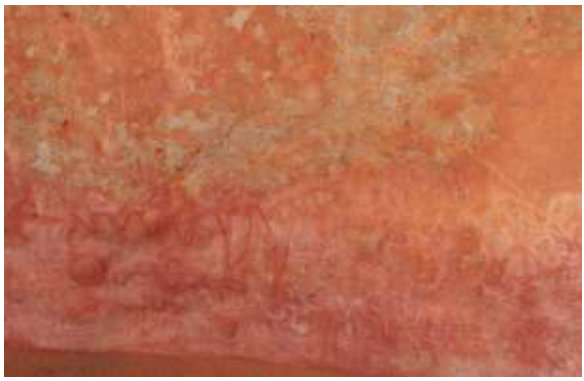
Figure 1. Screenshot of the coloured point cloud. After colour mapping and subsequent exporting of the point cloud data, the collinearity equations were used to perform the 3D to 2D transformation. The resultant 5 image bands are used to perform the image classification next. Figure 2 shows the five channel images in the left